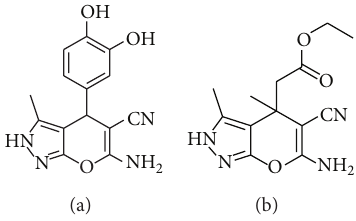
Figure 1: Some biologically potent